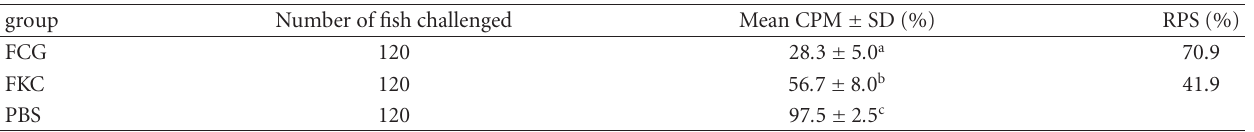
Table 1: Cumulative percent mortality (CPM) and relative percent survival (RPS) of grass carp following F. columnare G4 strain challenge at 50days after primary immunization.